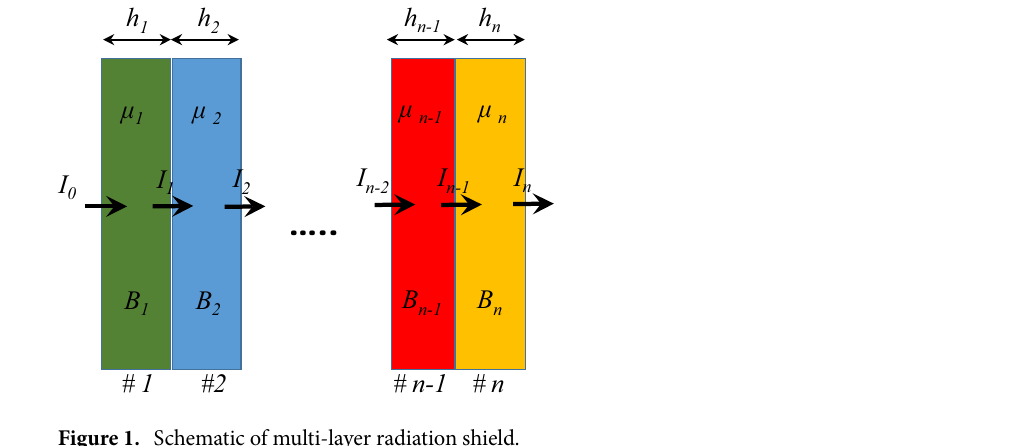
Figure 1. Schematic of multi-layer radiation